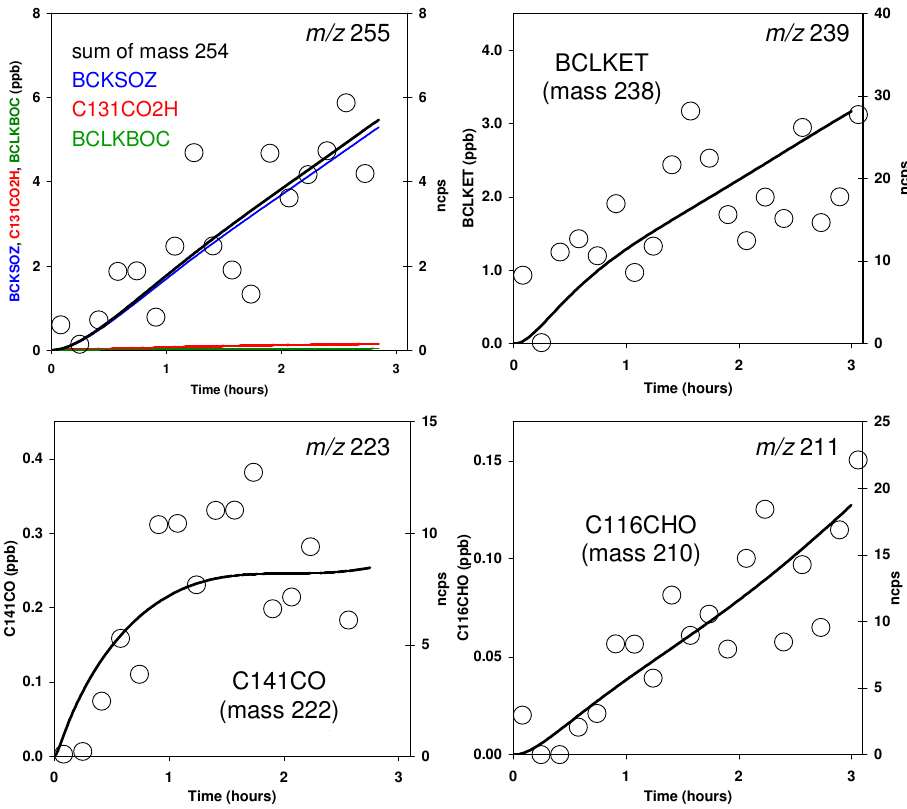
Fig. 17. Example time profiles simulated for selected higher- or multi-generation oxygenated products (lines), compared with those for corresponding product ion signals measured using CIR-TOF-MS (points), during ACES photo-oxidation experiments. Measured signals are presented as normalised counts per second (npcs), and the values for a given m / z incorporate the corresponding daughter ion signals identified in Table 3. Comparisons are for experiment 30-06-08 ( m / z 223), 03-07-08 ( m / z 255), 10-07-08 ( m / z 239 and 211). C141CO is formed partially during the first-generation of oxidation.